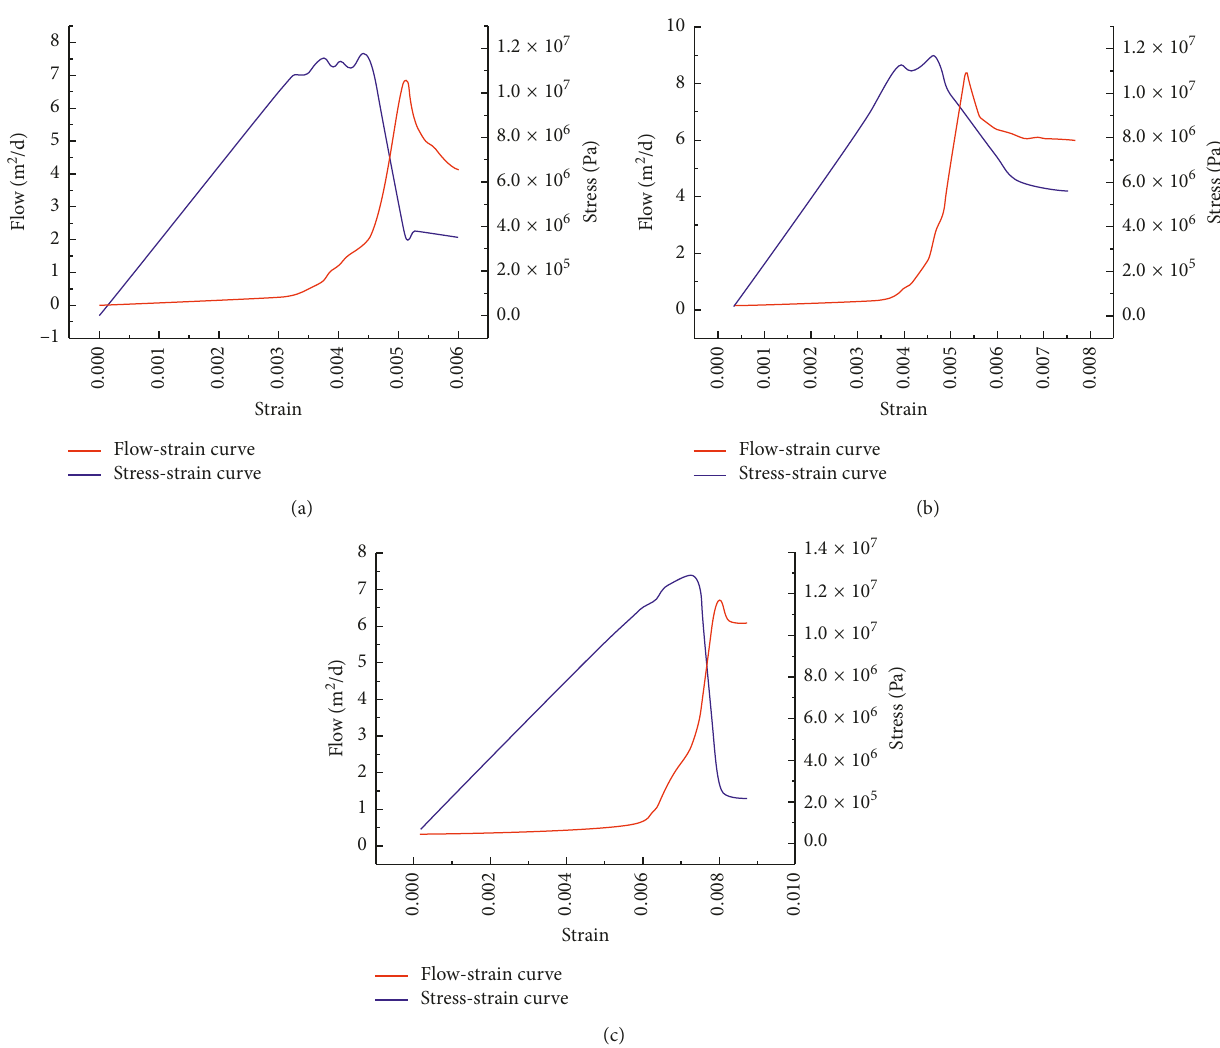
Figure 6: Evolution of stress and permeation under uniaxial compression with different angles. (a) β